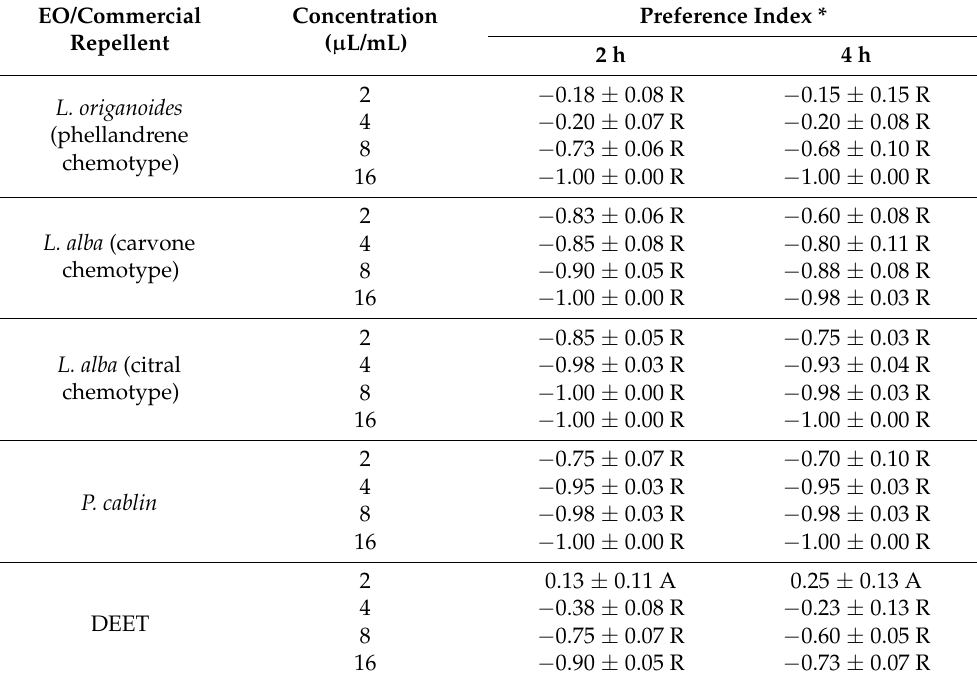
Table 3. Preference index (PI) for insects treated with essential oils or commercial repellent in different concentrations after two exposure times.